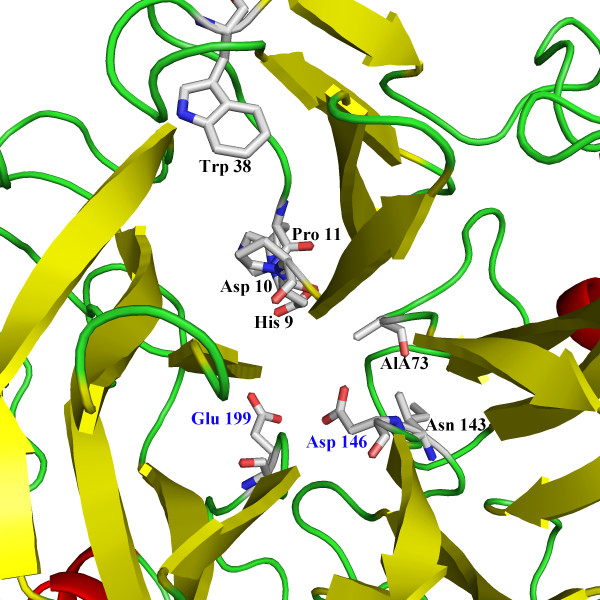
Predicted three-dimensional structure of Tth Abn. The potential catalytic amino acid residues are Asp146 and Glu199.